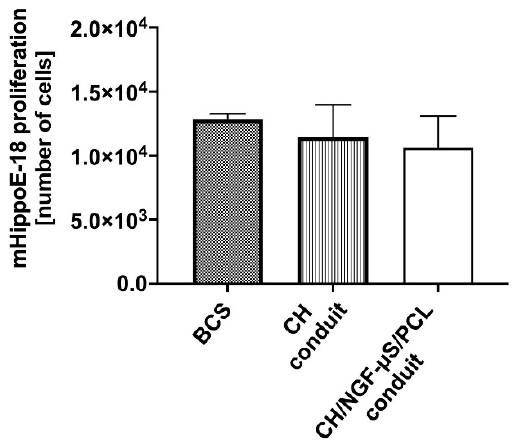
Figure 9. Proliferation of mHippoE-18 cells in response to CH and CH/NGF- µ S/PCL conduits in comparison to proliferation rate in the presence of the reference material (BCS). Data are shown as mean from three repeats with error bars that indicate standard deviation. Data were compared using an ordinary one-way ANOVA followed by Tukey’s multiple comparisons.